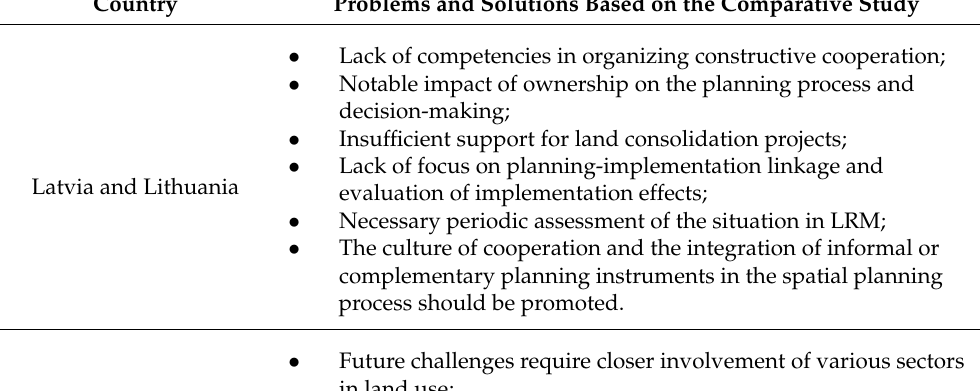
Table 6. Key problems and tools for their solutions in selected countries. Country Problems and Solutions Based on the Comparative